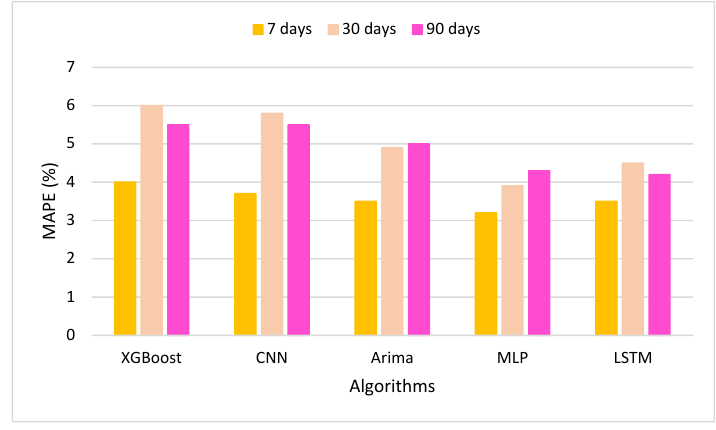
Figure 12. MAPE of the classification model.